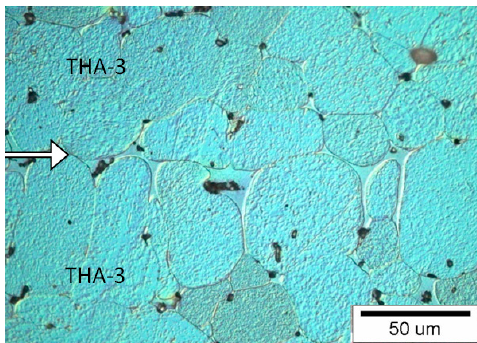
Figure 5. View of the microstructure of the THA-3 with THA-3 at a magnification 500× (the connection line (joint) is shown by the arrow).